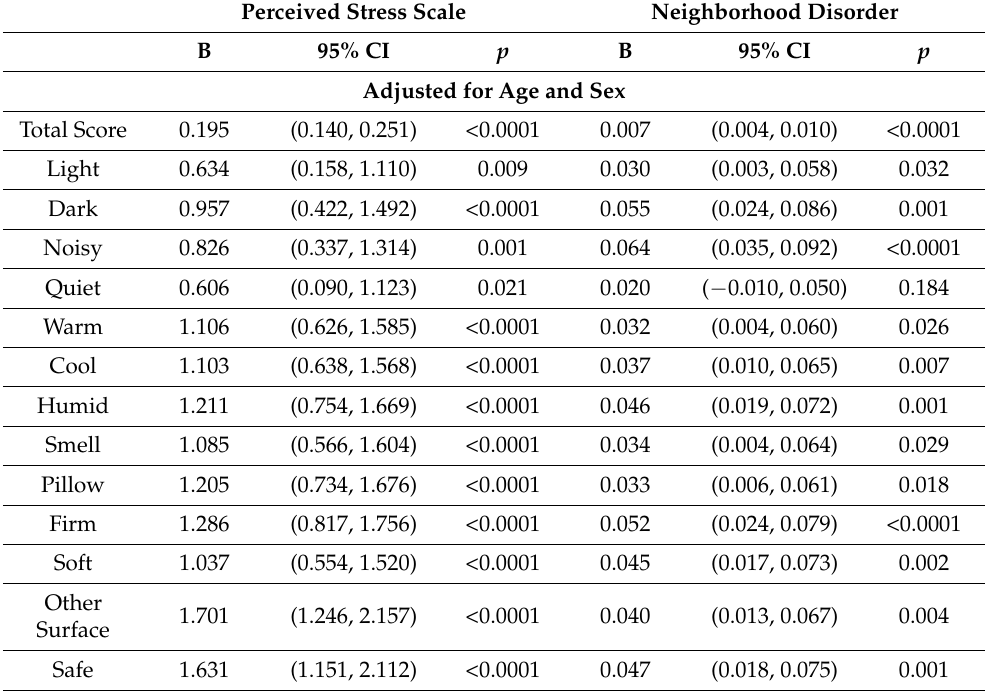
Table 4. Relationships between ASE Items and Related Factors of Perceived Stress and Neighbor- hood